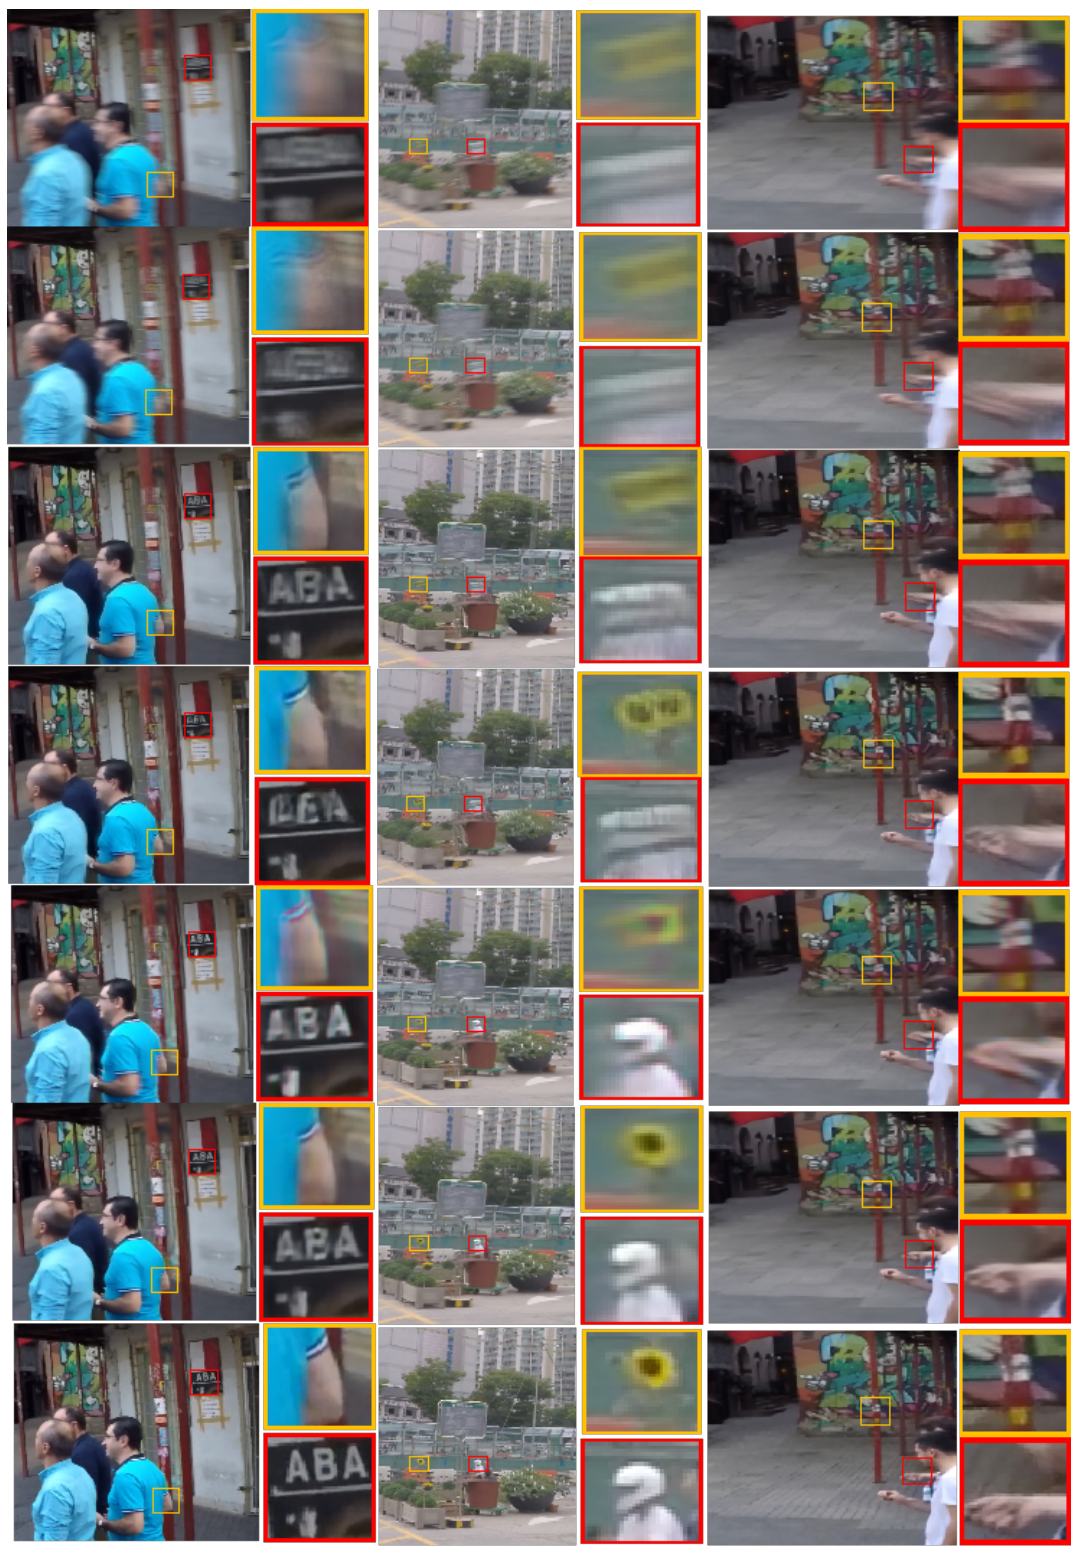
Figure 4. Subjective results of the GoPro test images. From top to bottom are the blurry images, the results of DeblurGAN (GAN = Generative Adversarial Network) [20], DeblurGAN-v2 [21], BAG [34], Gao’s method [38], our method, and the ground